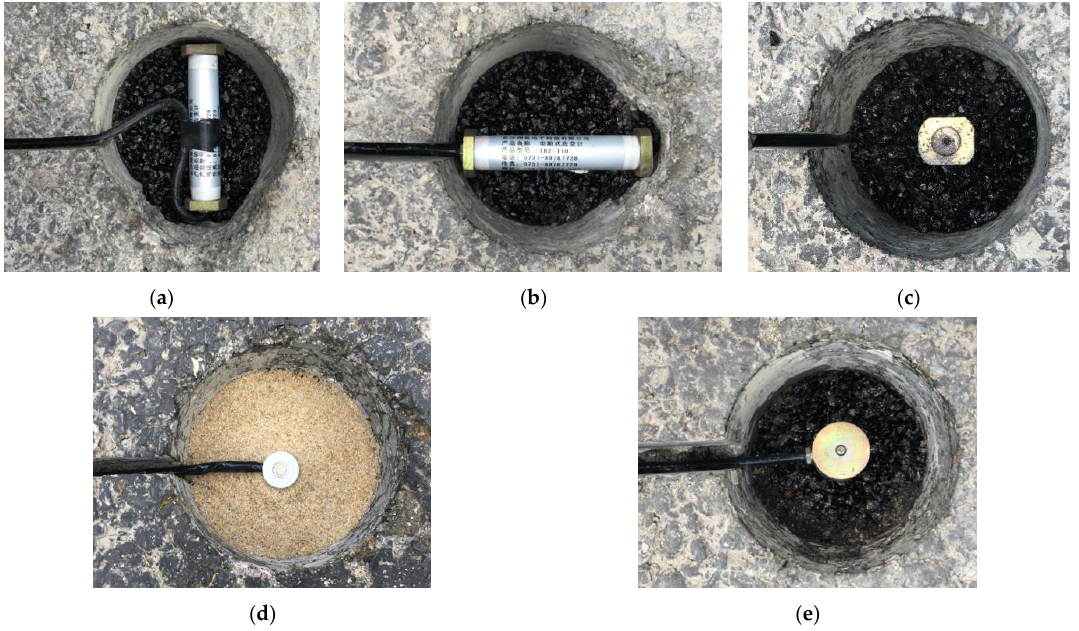
Figure 6. Buried sensors: ( a ) Longitudinal sensor; ( b ) Transverse sensor; ( c ) Vertical sensor; ( d ) Pore water pressure sensor; ( e ) Stress sensor.